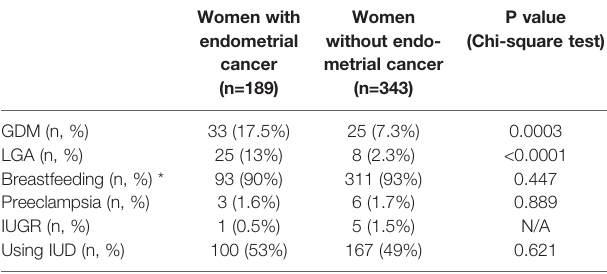
TABLE 2 | The association of complications of pregnancy and endometrial cancer. Women with endometrial